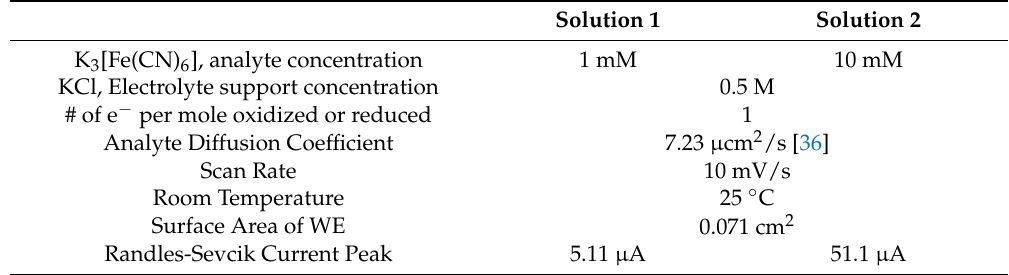
Table 2. Randles-Sevcik parameters and expected maximum current from CV and LSV experiments.